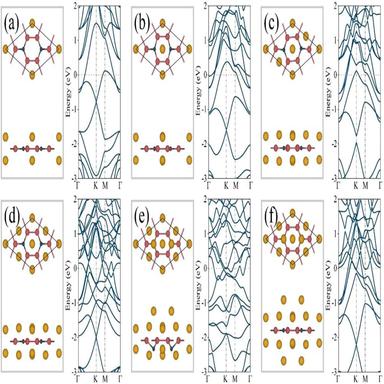
Optimized adsorption configurations and band structures of (a) (LiSi3C)2, (b) (Li2Si3C)2, (c) (Li3Si3C)2, (d) (Li4Si3C)2, (e) (Li5Si3C)2 and (f) (Li6Si3C)2. The Fermi level is set to zero.